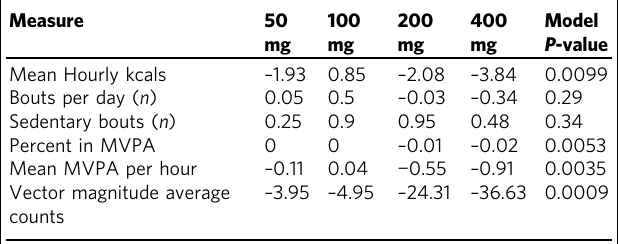
Table 6 Results from actigraphy analysis